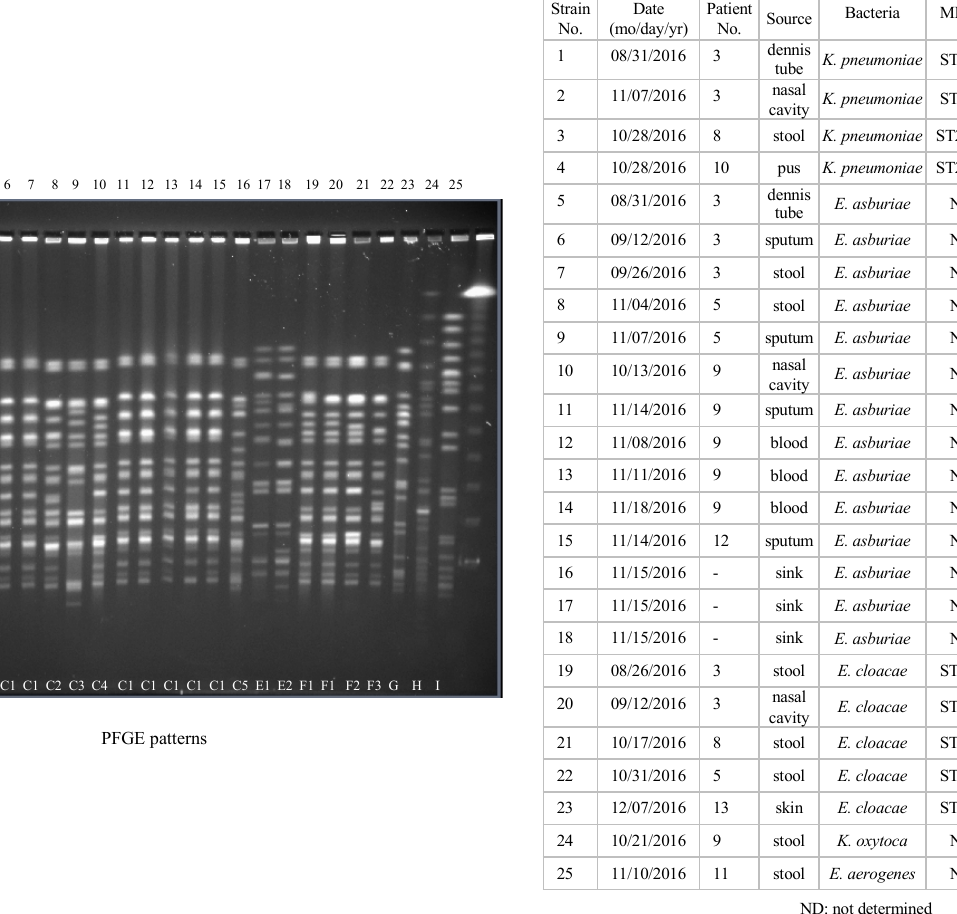
Figure 2. PFGE patterns of Xba I-digested DNA from 25 CRE isolates (22 from inpatients and 3 from environments). Molecular typing showed that the PFGE patterns of 25 CRE isolates were divided into eight patterns (A–I). Those of K. pneumoniae in strains three and four, E. asburiae from strains 5 to 16, and E. cloacae strains from strains No.19 to 22 were closely related. Similarly, the MLST patterns of 2 K. pneumoniae in strains three and four were identical as ST2388 and those of four E. cloacae strains from strains 19 to 22 were identical as ST252.